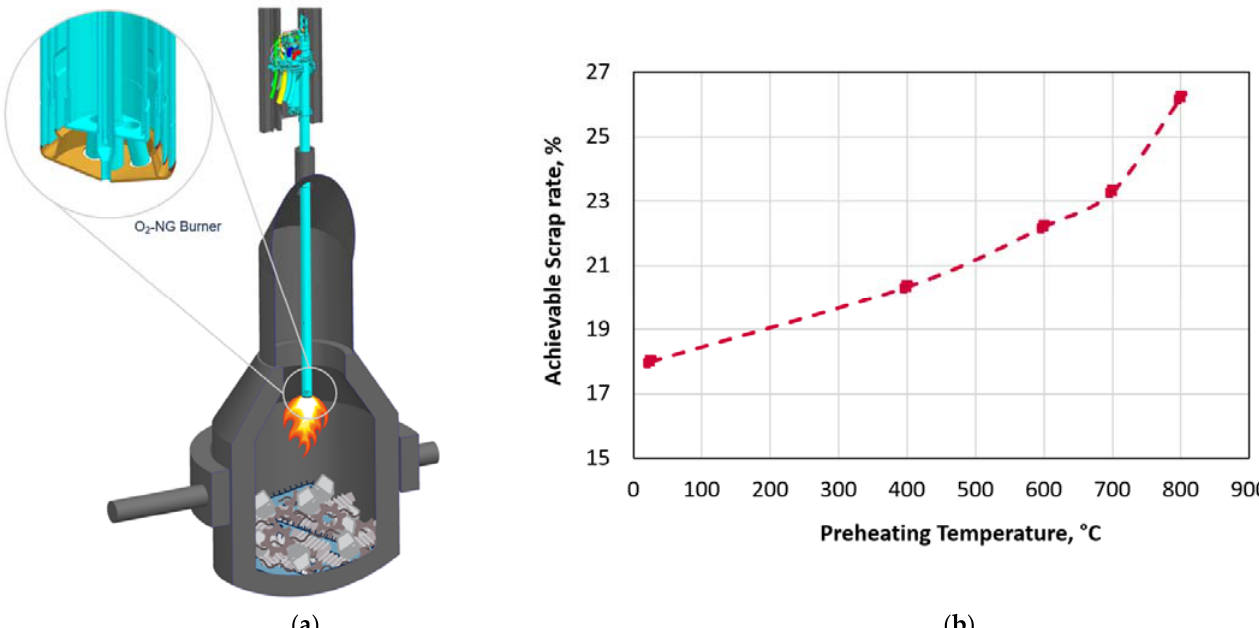
Figure 7. ( a ) O 2 Natural Gas Burner used as scrap preheating lance inside the BOF. ( b ) Influence of scrap preheating temperature on scrap rate at defined burner power.